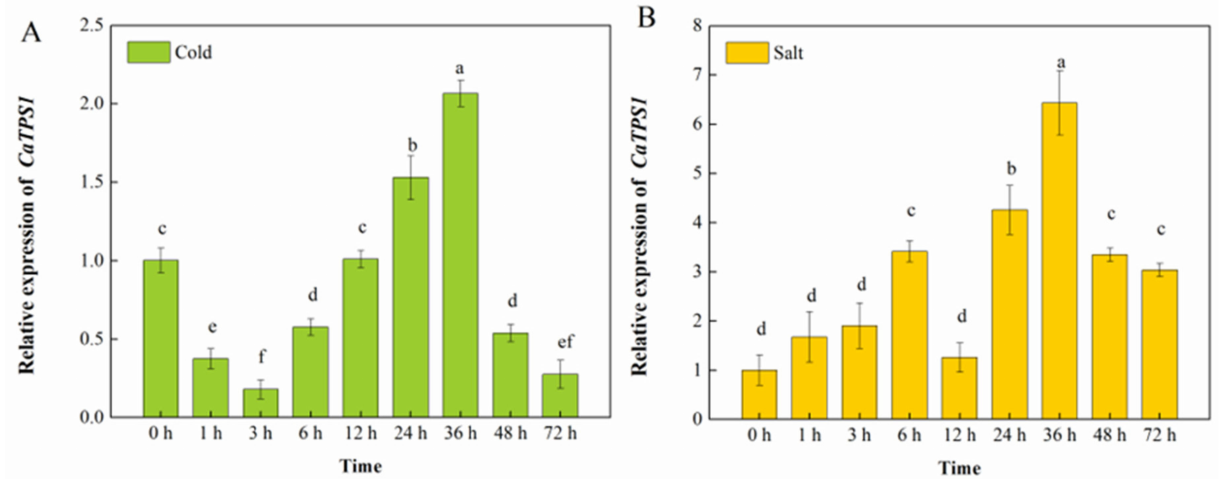
Figure 2. Relative expression of CaTPS1 . Relative expression of CaTPS1 in leaves from pepper under cold ( A ) and salt ( B ) treatments for 0 h, 1 h, 3 h, 6 h,12 h, 24 h, 36 h, 48 h and 72 h. Each value is shown as the mean ± standard error of three biological replicates, and the multiple comparison test for each gene was presented. Different letters stand for significant differences between CK, TRV2-00, and TRV2- CaTPS1 plants (Duncan’s test, p <